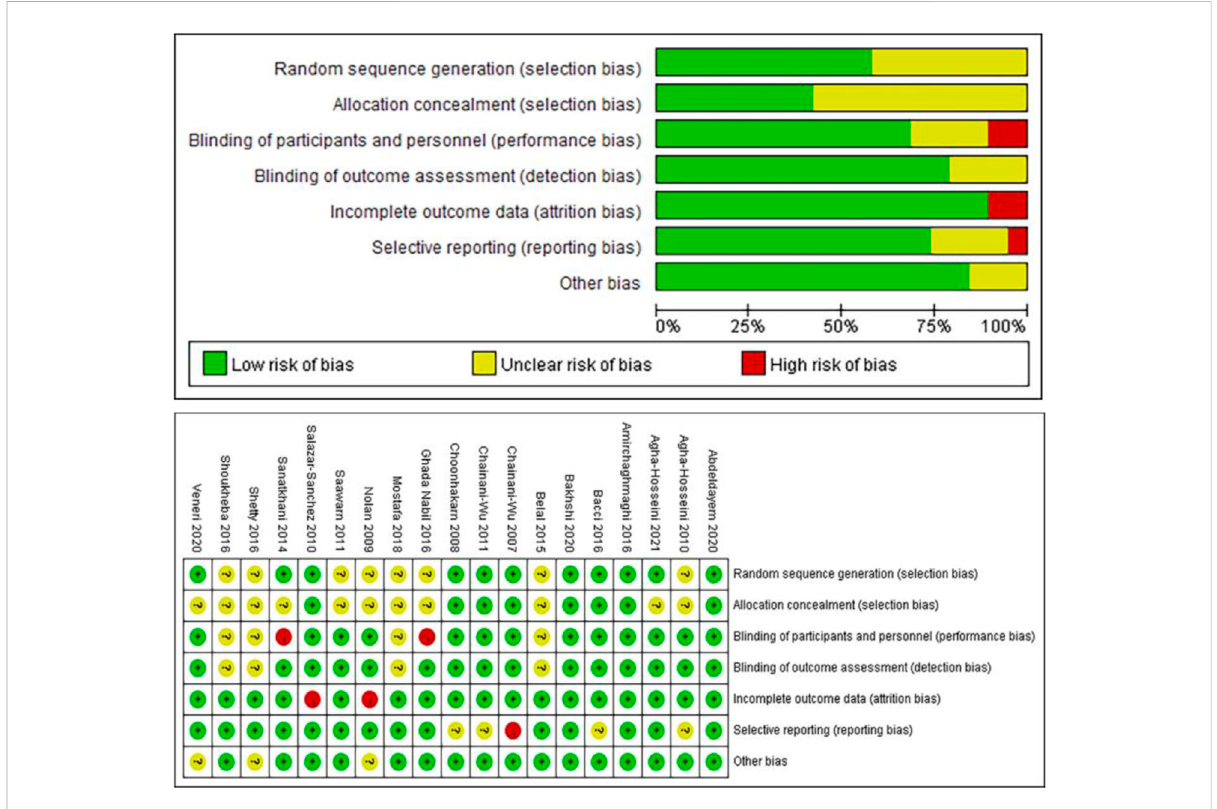
FIGURE 2 Risk of bias of the included studies (Cochrane